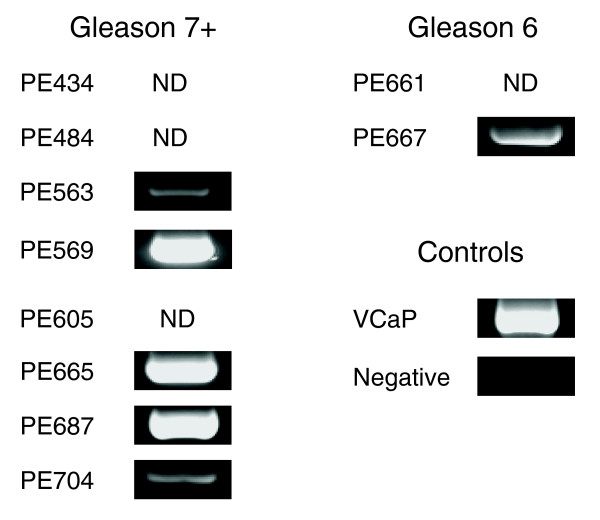
Nested RT-PCR for the detection of the TMPRSS2:ERG fusion. Samples from the microarray data set, where sufficient material was available, were subjected to nested RT-PCR to detect the presence of the TMPRSS2:ERG fusion product. The fusion product was detected in 6 of 10 samples and undetectable in the remainder (samples marked ND). cDNA from the fusion positive cell line VCaP was used as a positive control, water was substituted in place of cDNA for the negative control.